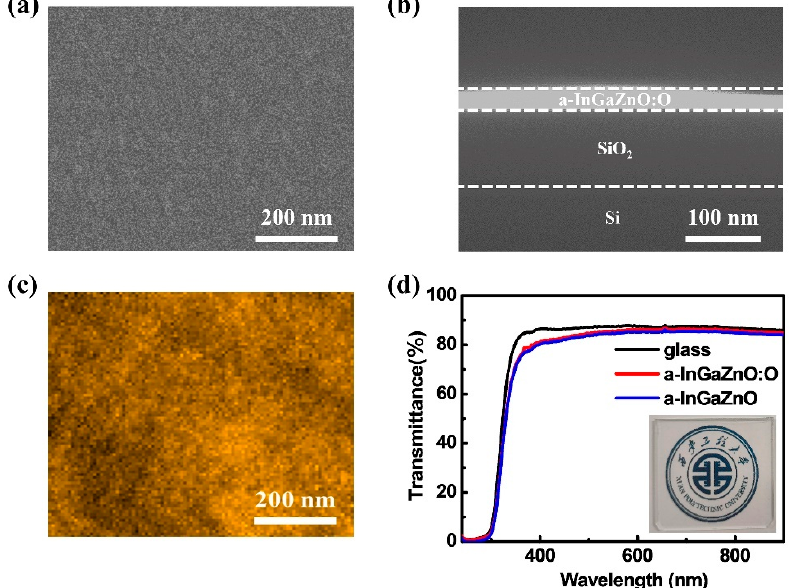
Figure 5. ( a ) SEM images of the surface and ( b ) cross-section of a 20 nm thick a-InGaZnO:O channel layer; ( c ) AFM image of 20 nm thick a-InGaZnO:O channel layer; ( d ) curves of optical transmittance of glass and a-InGaZnO-based thin film as a function of wavelength. The inset is the photo of an a-InGaZnO:O film (20 nm) on the school emblem.